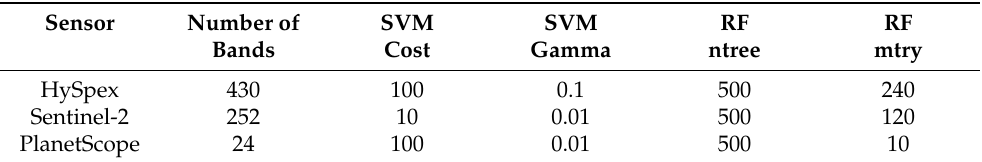
Table 2. Selected input hyperparameters of algorithms (random forest and support vector machine) using grid search